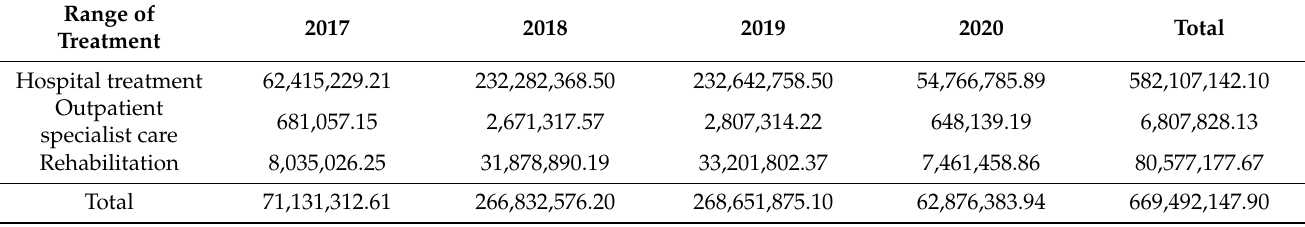
Table 4. Total costs of treatment (in EUR) of patients not covered by CCMI.